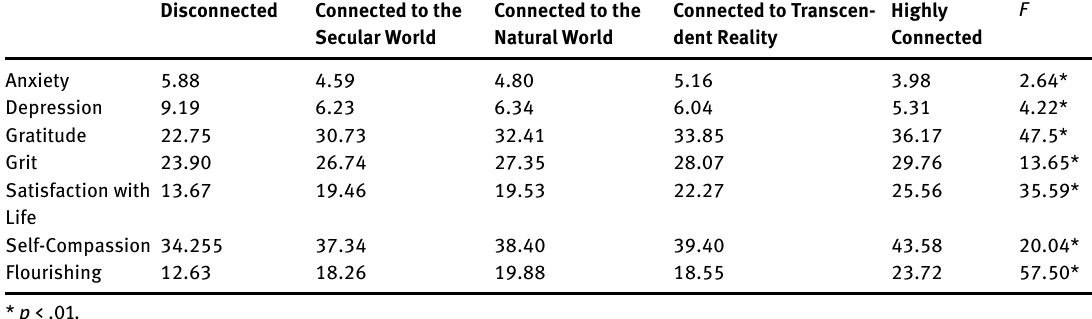
Table 3. One-way ANOVA of variable means across five classes of spiritual connection.